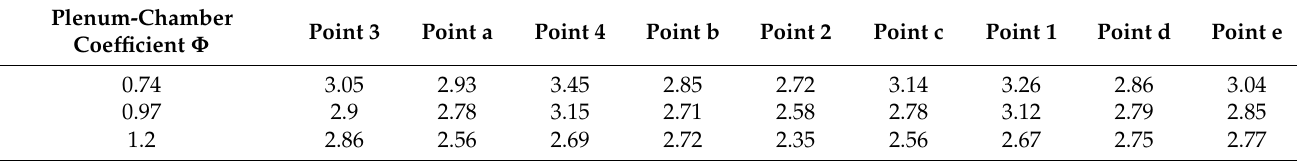
Table 3. Air flow rate at each measuring point of the inlet under different plenum-chamber coefficients.